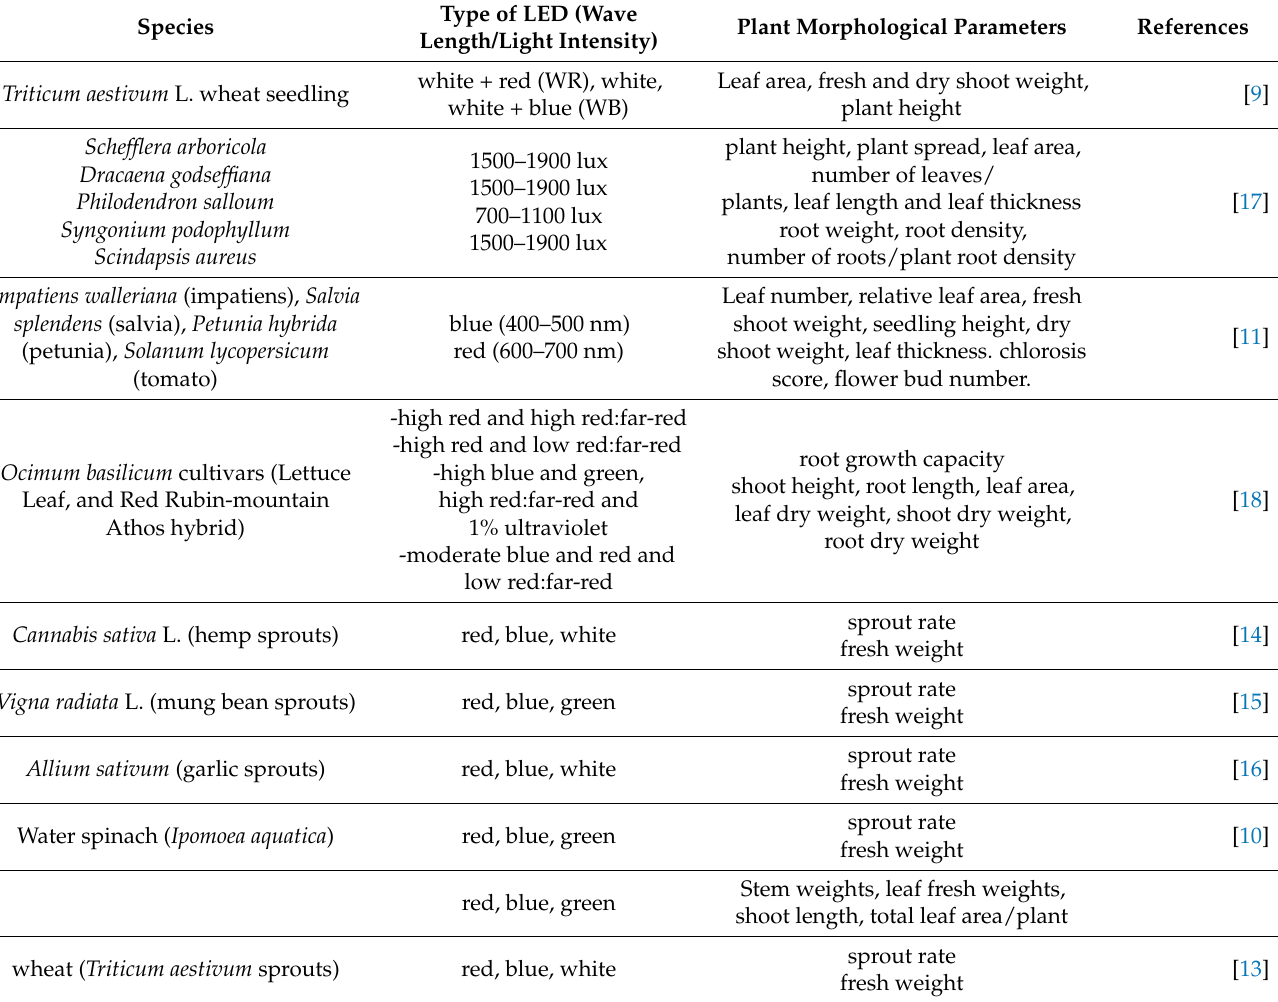
Table 1. LED treatment and the effect on plant morphological and developmental parameters